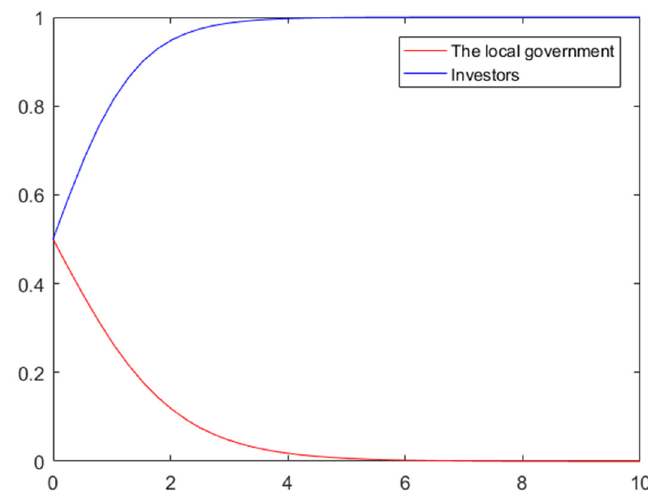
Figure 4. Simulation results in the bubble formation stage .